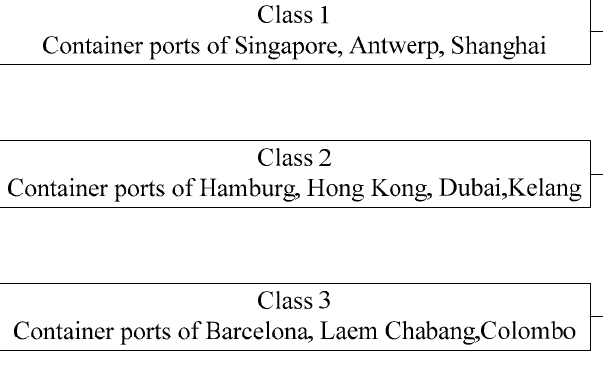
Figure 3. The three classes of the 10 container ports along the MSR.